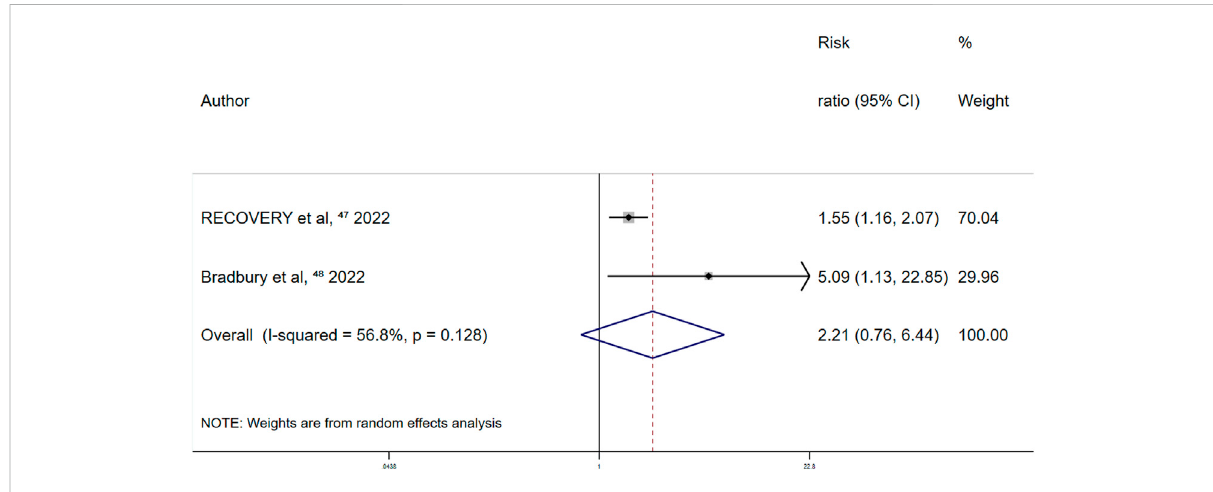
FIGURE 12 Summary hazard ratio of bleeding events for heprin use in randomized controlled